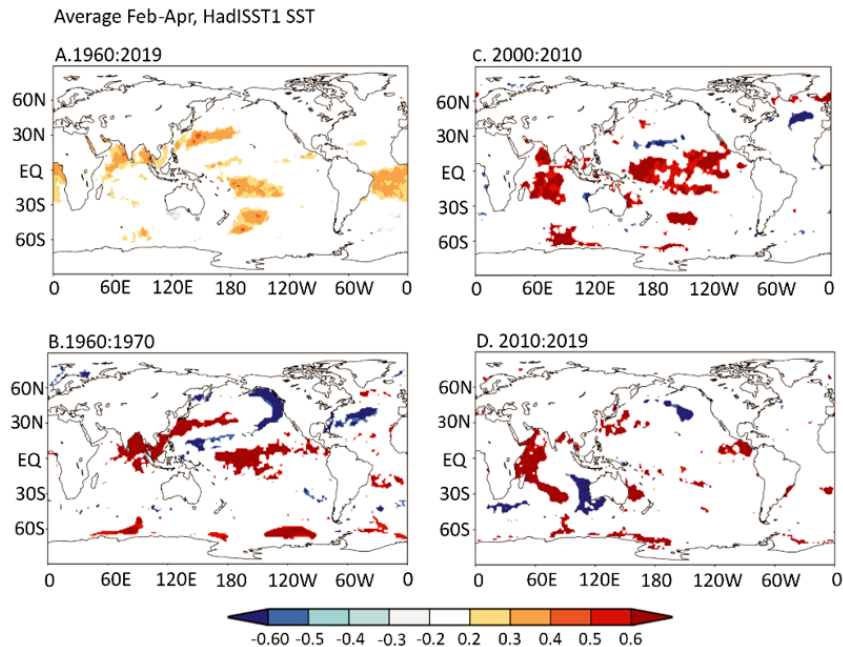
Figure 7. Spatial correlations of our mean tree-ring δ 18 O TRC chronology with HadlSST1 sea surface temperatures (SST) for the spring season (Feb-Apr) for the periods 1960–2019 CE ( A ), 1960–1970 CE ( B ), 2000–2010 CE ( C ), and 2010–2019 CE ( D ); areas with p > 0.10 are